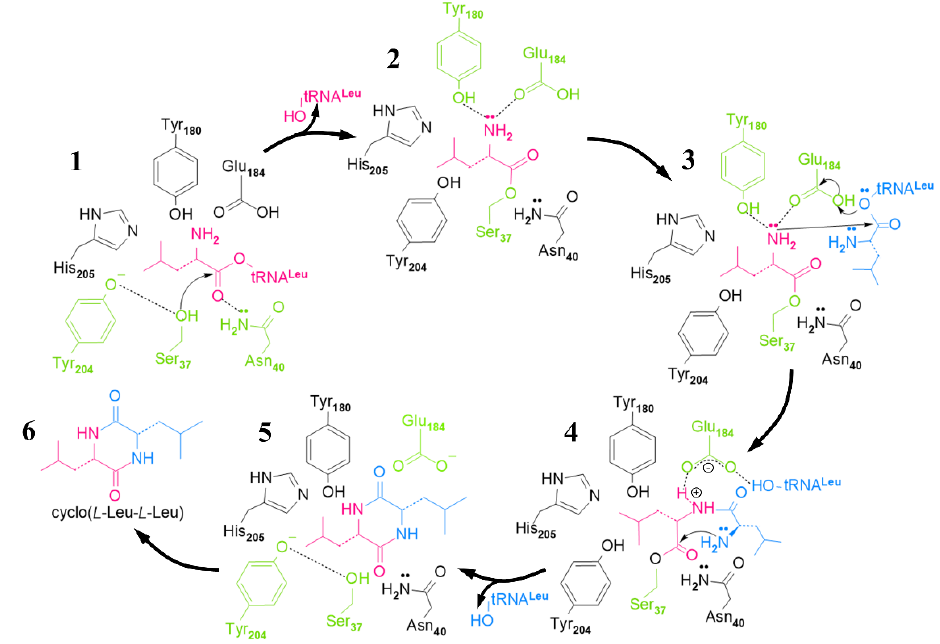
Figure 6. Mechanism of cyclo ( L -Leu- L -Leu) (cLL) synthesis catalyzed by B. licheniformis YvmC. The Leucyl moiety of the first and second combined Leu-tRNA Leu is highlighted in red and blue, respectively [14].